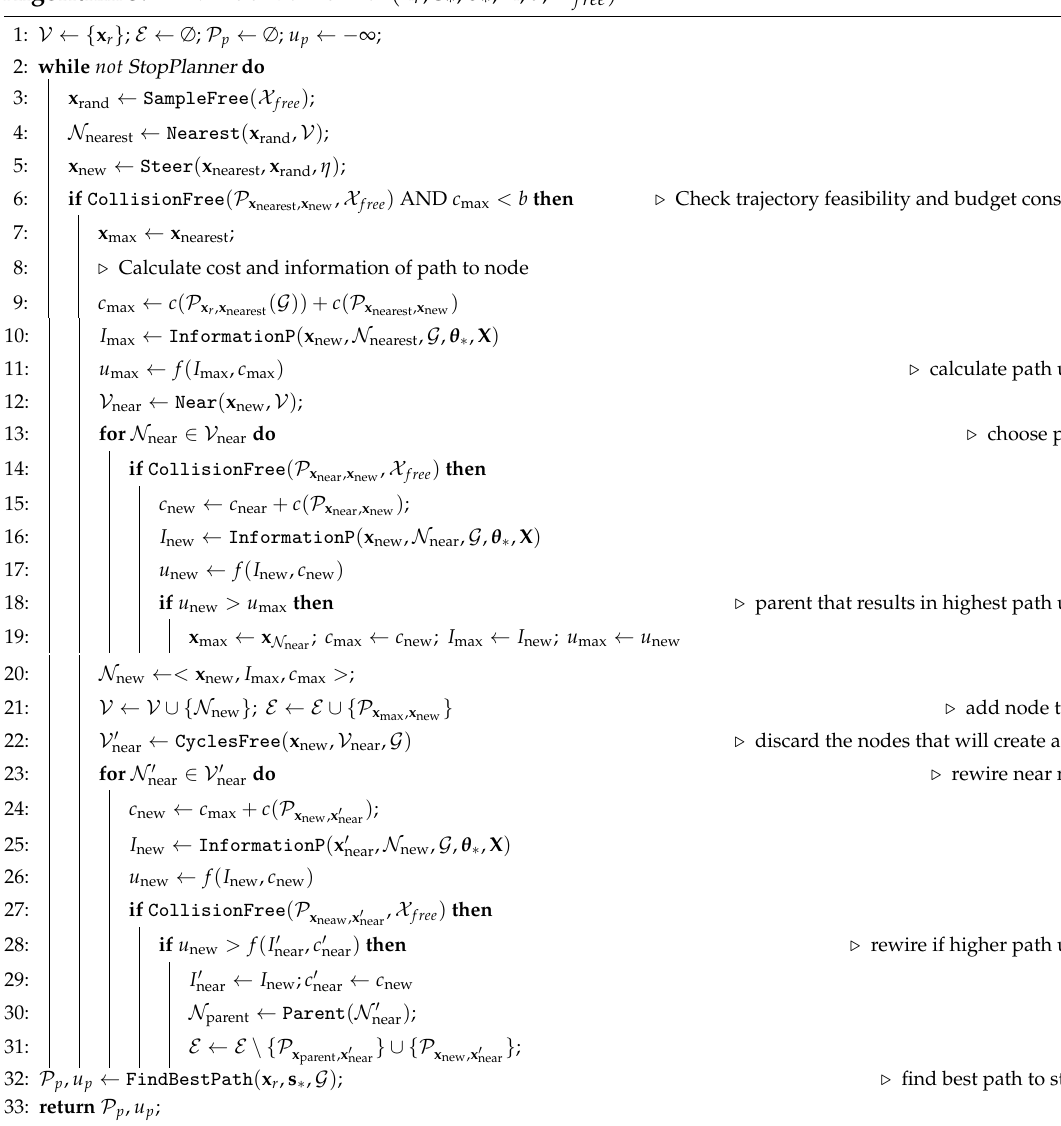
Algorithm 3. InformativePlanner ( x r , s